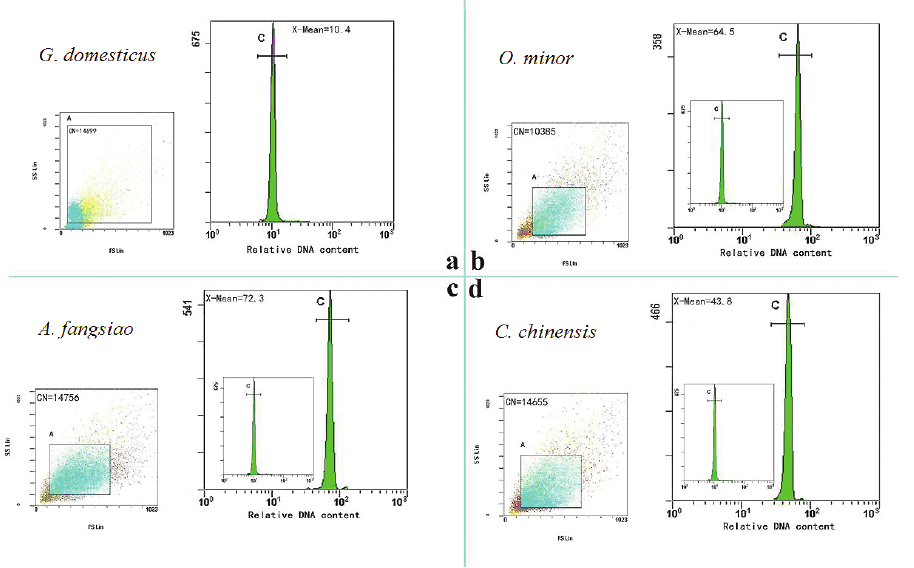
Figure 4. Flow cytometry profiles of relative fluorescence intensity of propidium iodide (PI) in octopus hemocytes of b O. minor c A. fangsiao and d C. chinensis with G. domesticus a as standard (St). Scatter plots display the quality and number of cell mass of standard samples and test samples, and the peak fig- ures show the relative DNA content of each sample. b , c and d are just a representative graph of the three species of octopus samples. CN, the number of cells; X-MEAN, mean fluorescence